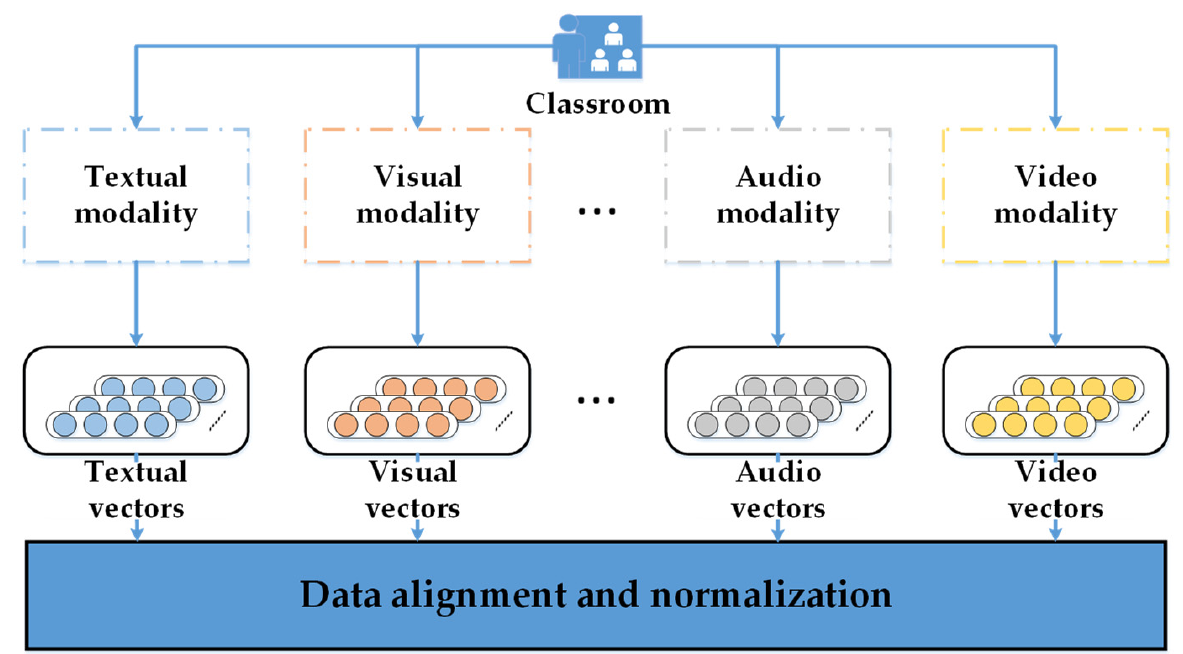
Figure 2. Representation, normalization, and alignment of cross-modal learning behavioral data.